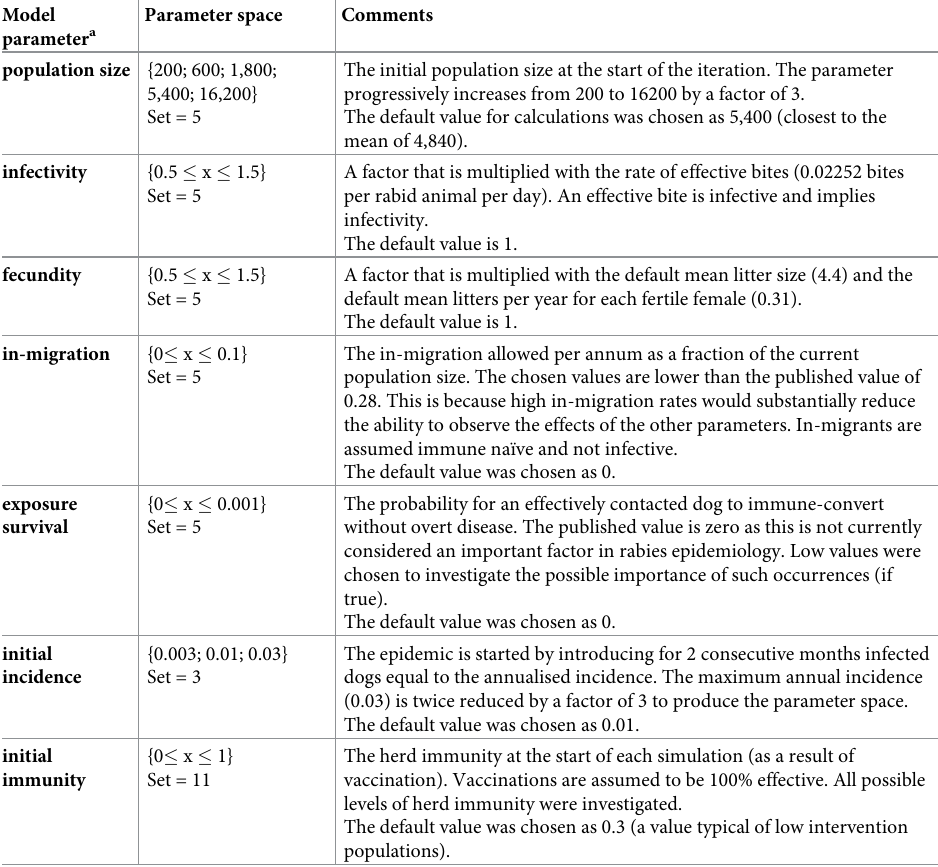
Table 1. Model parameters included in the transmission